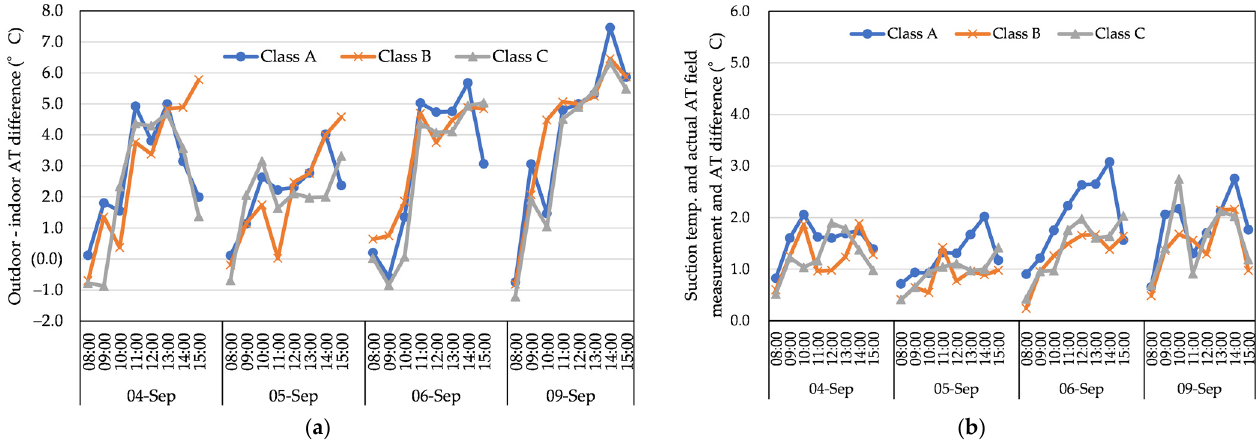
Figure 23. AT differences. ( a ) AT difference between outdoor and indoor AT. ( b ) AT difference between actual air temperature field measurement data and air temperature data collected with the PFI method in the summer season.